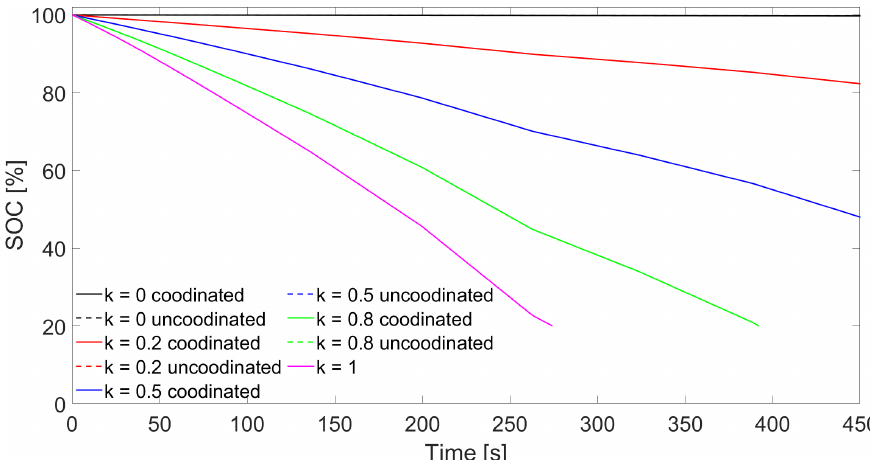
Figure 11. Effect of k and coordination on battery discharge.